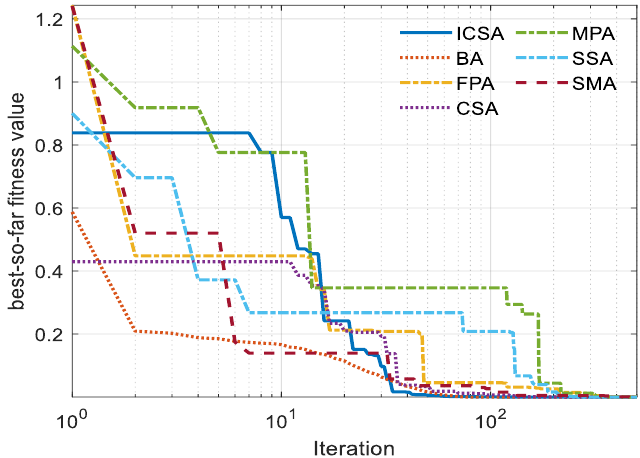
Figure 7. Convergence curve for F7.